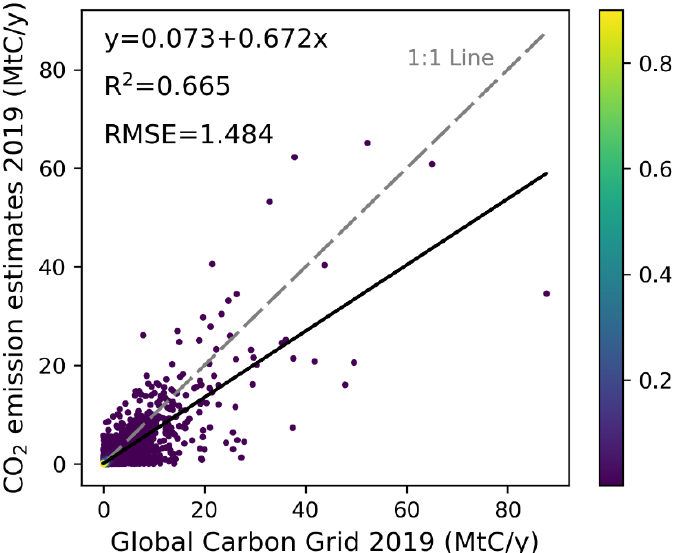
Figure 10. Scatterplots between our gridded emission estimates and Global Carbon Grid data in 2019. The color indicates the kernel density calculated by the Gaussian kernel of the points.